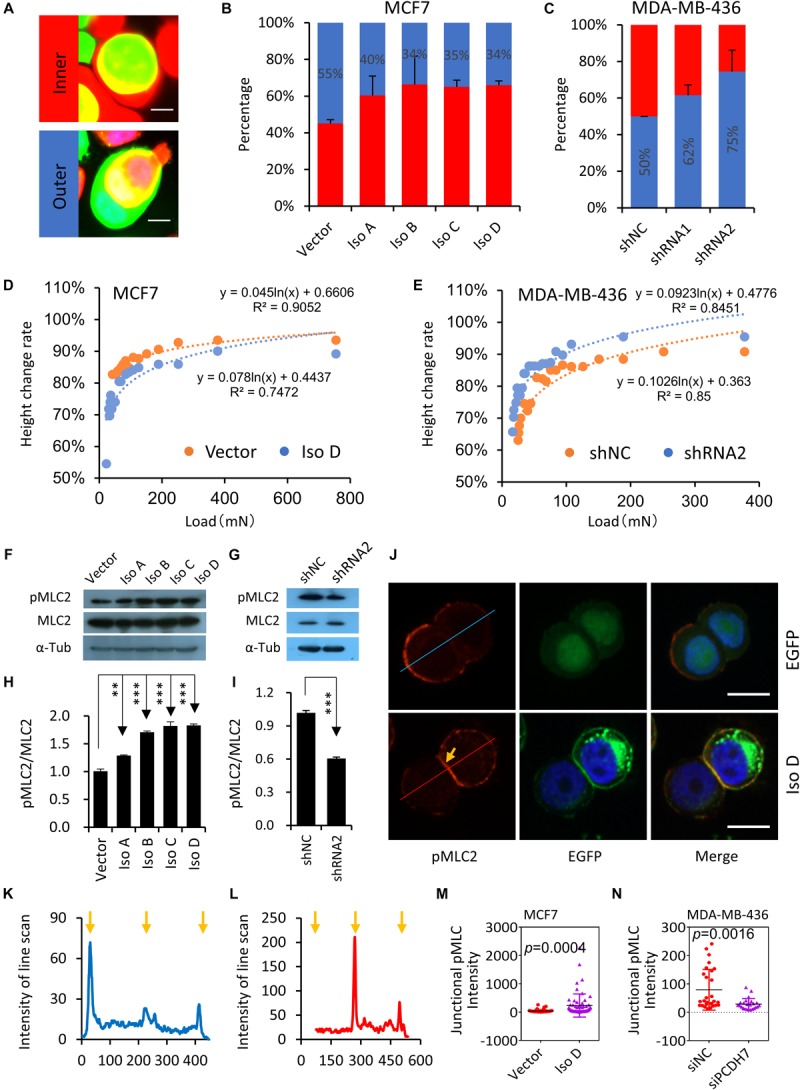
PCDH7 enhances actomyosin contraction and cell stiffness. (A) Images depicting the relative identities of EGFP-expressing cells. Scale bar: 10 μm (B)
PCDH7 overexpression (EGFP +) promotes cells internalization as inner cell. n > 60 CIC structures each. Data are mean ± SD of triplicate experiments. P < 0.05 for isoforms compared with control. (C)
PCDH7 depletion (EGFP +) confers cells the identity of outer cell. n > 60 CIC structures each. Data are mean ± SD of triplicate experiments. P < 0.05 for two hairpins compared with control. (D,E) Deformation of cells with PCDH7 overexpression (D) or depletion (E) as determined by compression assay. (F,G) Expression of pMLC2 and MLC2 upon PCDH7 overexpression (F) or depletion (G). (H,I) Quantification of the ratio of pMLC2/MLC2 in (F) or (G), respectively. ∗∗P < 0.01; ∗∗∗P < 0.001. (J) Representative images for pMLC2 staining (red) in MCF7 cells. Arrow indicates junctional pMLC2. Scale bar: 15 μm. (K,L) Relative intensity of pMLC2 by line scan analysis. (K) and (L) are corresponding to upper (EGFP) and lower (Iso D) panels, respectively. Arrows indicate cell boundaries. (M,N) Quantification of junctional pMLC2 intensity upon PCDH7 overexpression (M) or depletion (N). n = 24∼60 junctional sites.